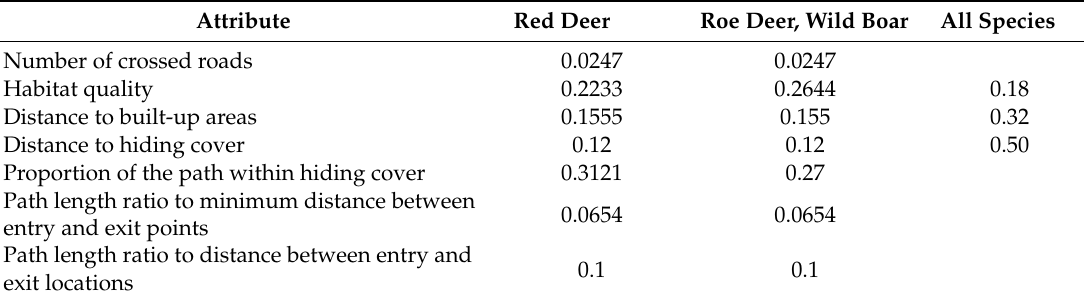
Table 3. Eigenvectors calculated based on Saaty’s analysis for red deer (consistency ratio = 0.03), roe deer and wild boar (consistency ratio = 0.025) and eigenvectors for all three